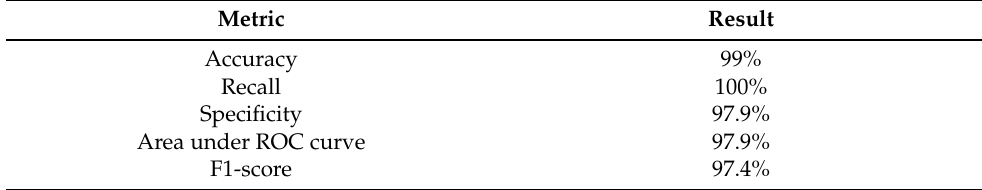
Table 4. Classifier performance evaluation